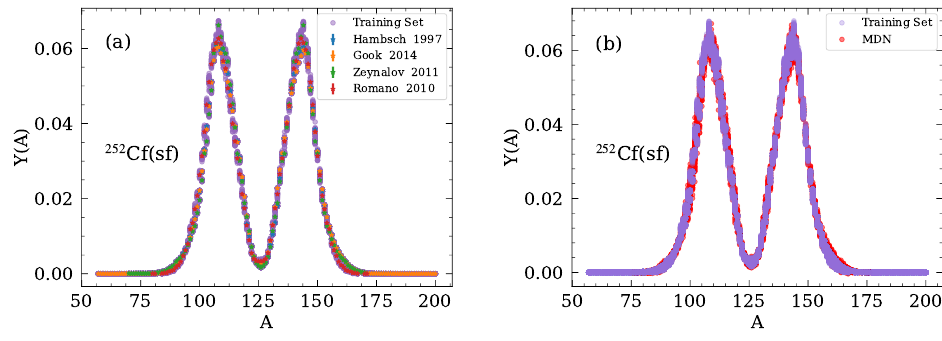
Figure 2. (a) Comparison between experimental mass yields for 252 Cf(sf) from [16–19] (colored stars) and the constructed training set for the MDN (purple circles). (b) MDN prediction (red) underlaid behind the training set